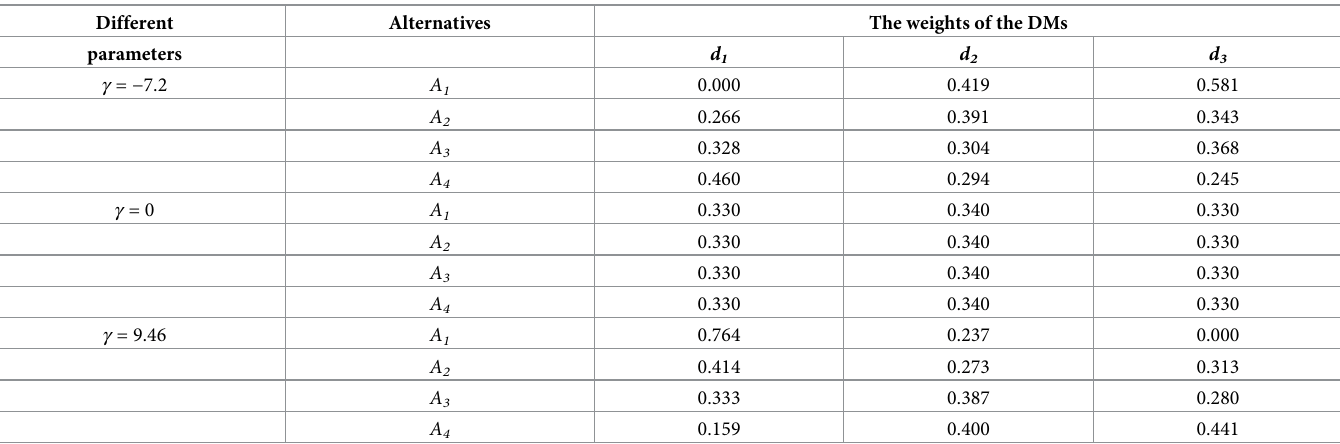
Table 4. The weights of the DMs in different situations.